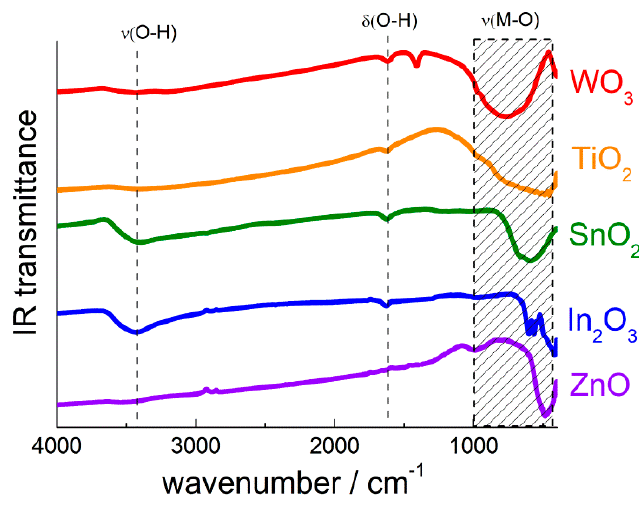
Figure 7. FTIR spectra of nanocrystalline n -type MOS. Adapted with permission from ref. [75] copy- right 2018 Elsevier; ref. [76] copyright 2019 Marikutsa, Rumyantseva, Gaskov, Batuk,